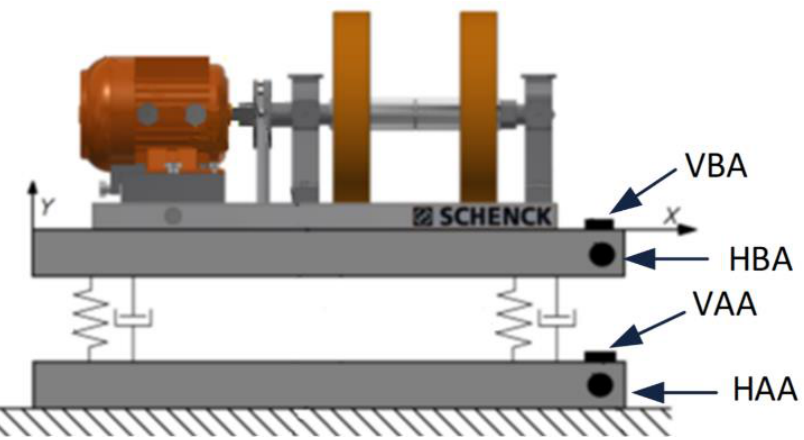
Figure 6. Test stand for dampers long-distance tests. Locations of accelerometers: VBA — vertical before absorber, VAA — vertical after absorber, HBA — horizontal before absorber, HAA — horizontal after absorber.